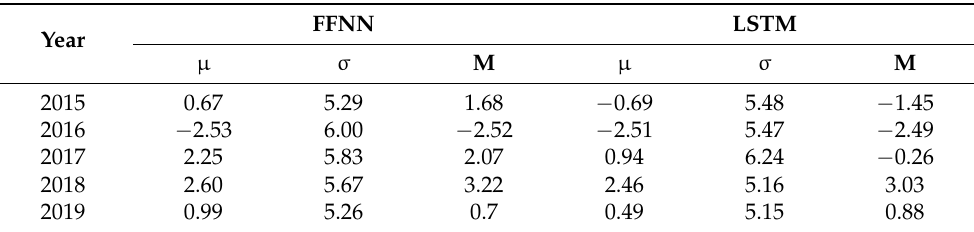
Table 9. Statistical error indicators—mean ( µ ), standard deviation ( σ ), and median (M), in EUR/MWh, for FFNN and LSTM errors.